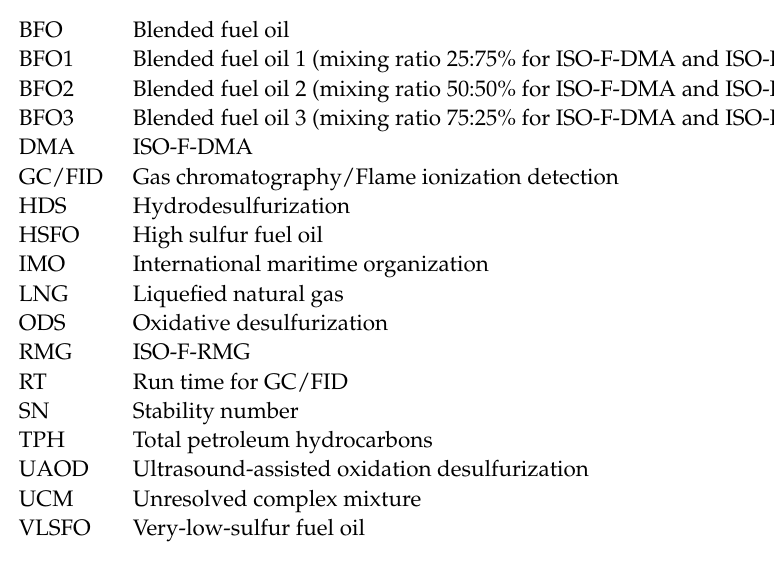
Figure S2: Variation on alkane peak ratio for BFO1; Figure S3: Variation on alkane peak ratio for